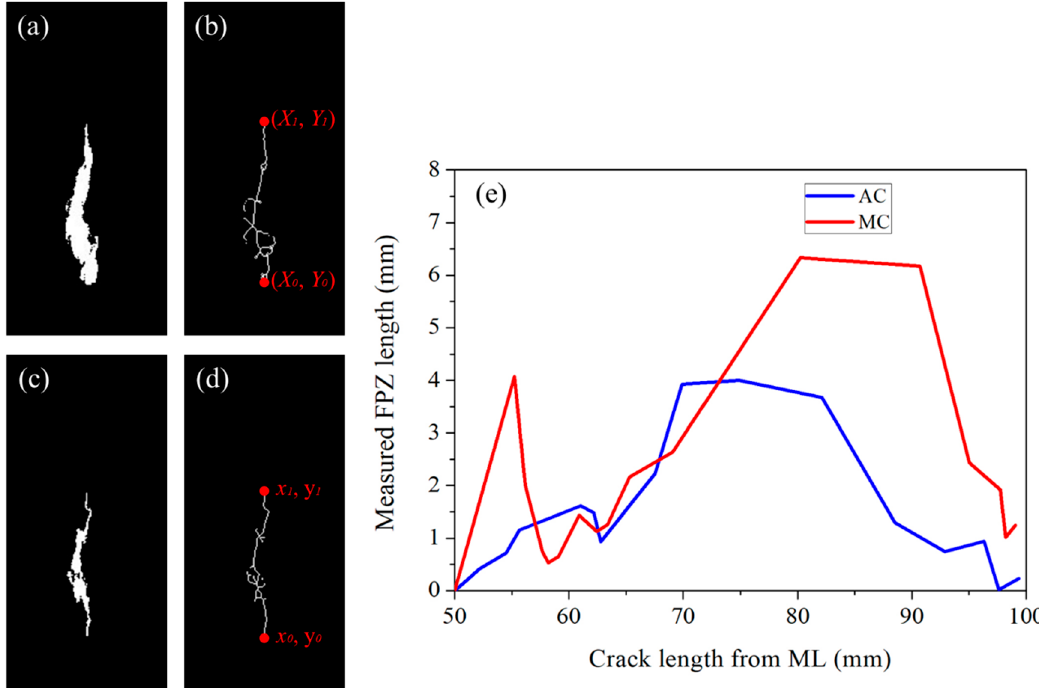
Figure 7. ( a ) Binary ML image of Figure 6a showing the ML pattern. ( b ) Skeleton image of ( a ). ( c ) Binary image of Figure 6e showing the crack after the exclusion of the First Zone and the Second Zone. ( d ) Skeleton image of ( c ). ( e ) Comparison of the FPZs of two different samples with crack lengths obtained from the skeleton images.